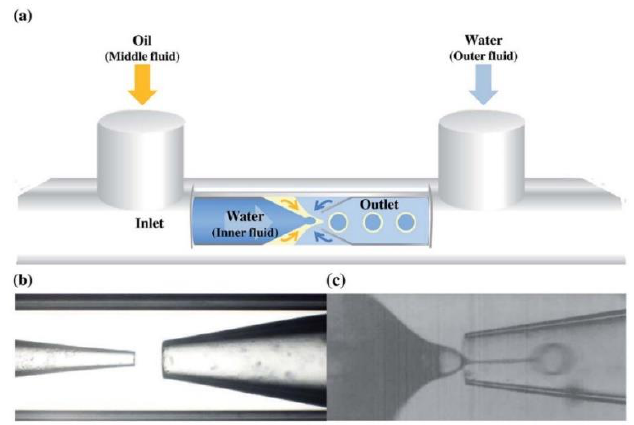
Figure 2. ( a ) Schematic of the capillary microfluidic device combining co-flow and flow-focusing geometries. Photographic images of the microfluidic capillary devices were used in the ( b ) absence and ( c ) presence of fluids. Reprinted with permission from ref. [67]. Copyright 2016 Royal Society of Chemistry.